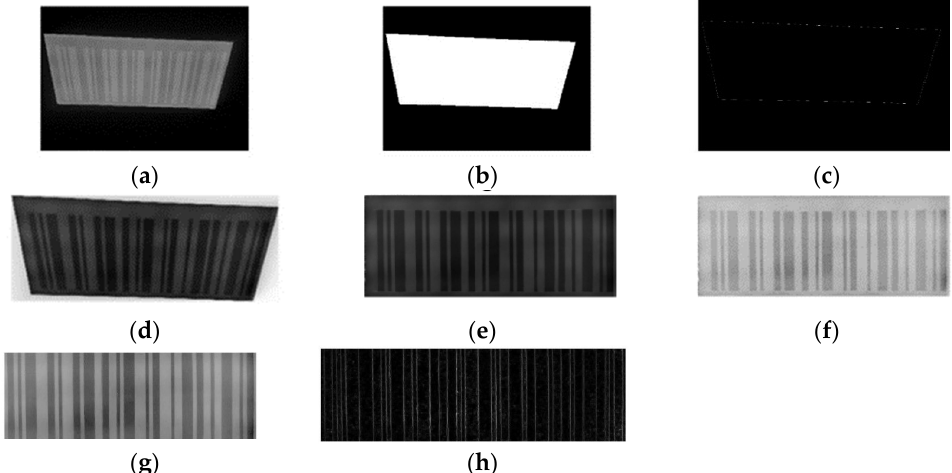
Figure 13. The result of each process of image processing of the acquired image: ( a ) original image; ( b ) binary image after threshold segmentation; ( c ) ROI boundary profile identification chart; ( d ) the corresponding area of the flat lamp split out in the original figure; ( e ) image after tilt correction; ( f ) image after adaptive lighting compensation; ( g ) image after histogram equalization; ( h ) image after edge recognition.